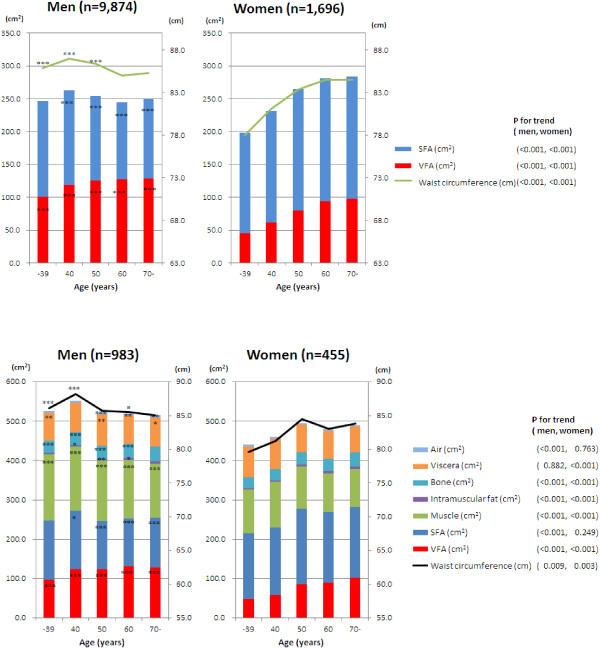
Mean body components according to the age group measured by CT. *P < 0.05, **P < 0.01, ***P < 0.001 for differences in mean values between men and women in each age group by t-test. P for trend across the age groups was calculated by a linear regression analysis where the age group was coded as consecutive integers.